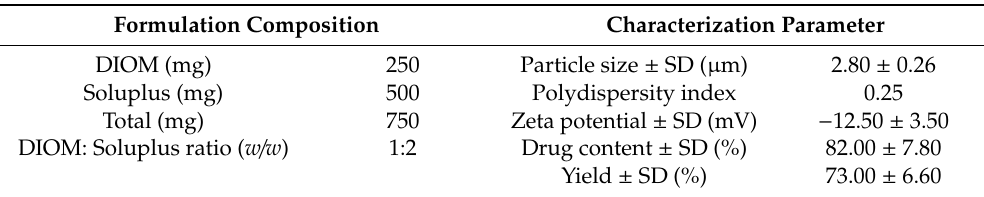
Table 1. The composition and characterization of in-house developed spray-dried microparticles (MPs) of diosmin (DIOM) (mean ± SD; n =